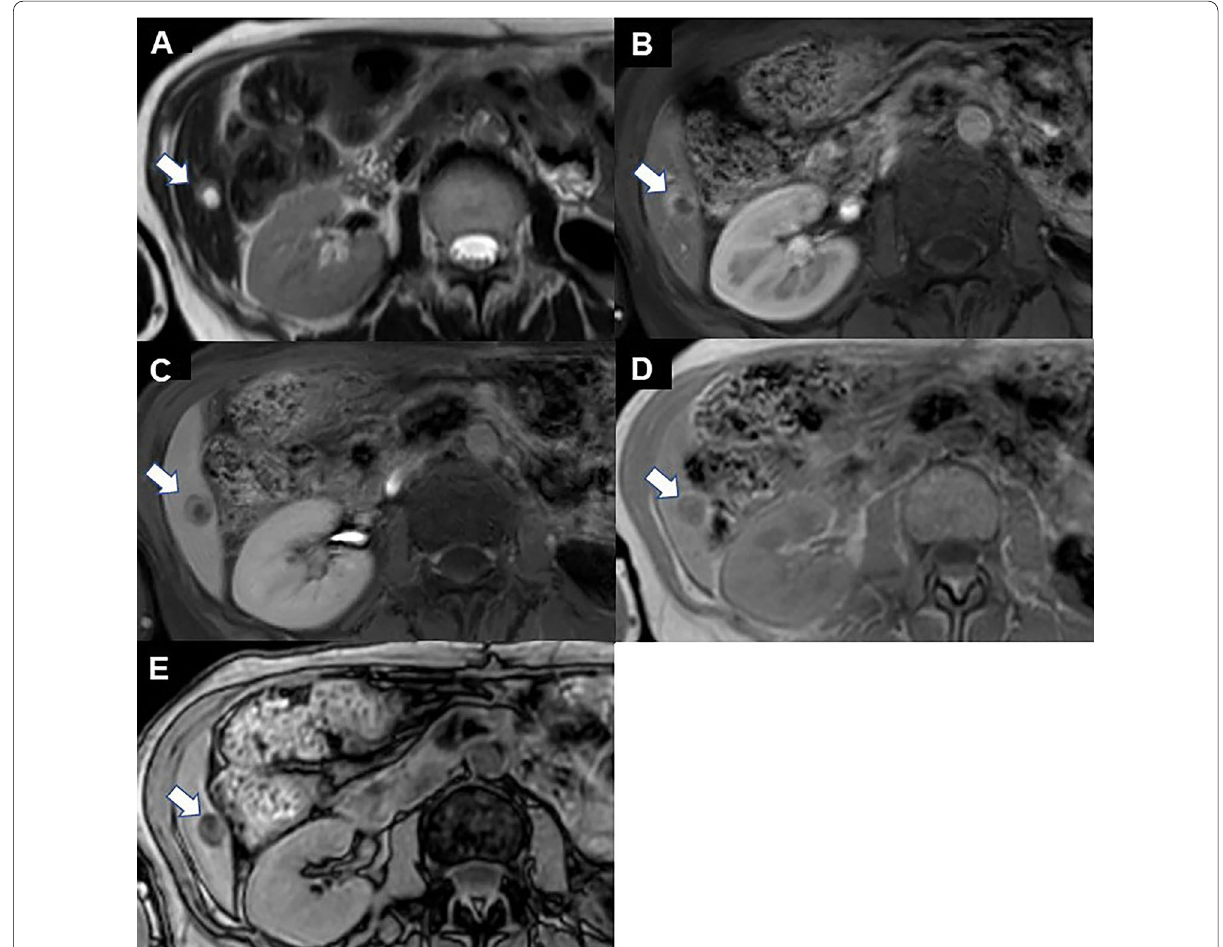
Fig. 1 Dynamic contrast-enhanced MRI of the abdomen. A A 16-mm mass lesion with both cystic and solid, lipid-containing components (arrow, T2WI). B Arterial phase (T1W1). C Portal phase (T1W1). The solid components demonstrated arterial enhancement followed by rapid washout in the portal phase (arrow, T1WI). D In-phase (T1W1). E Opposed-phase (T1W1). A signal drop can be observed on the opposed-phase image compared to the in-phase image